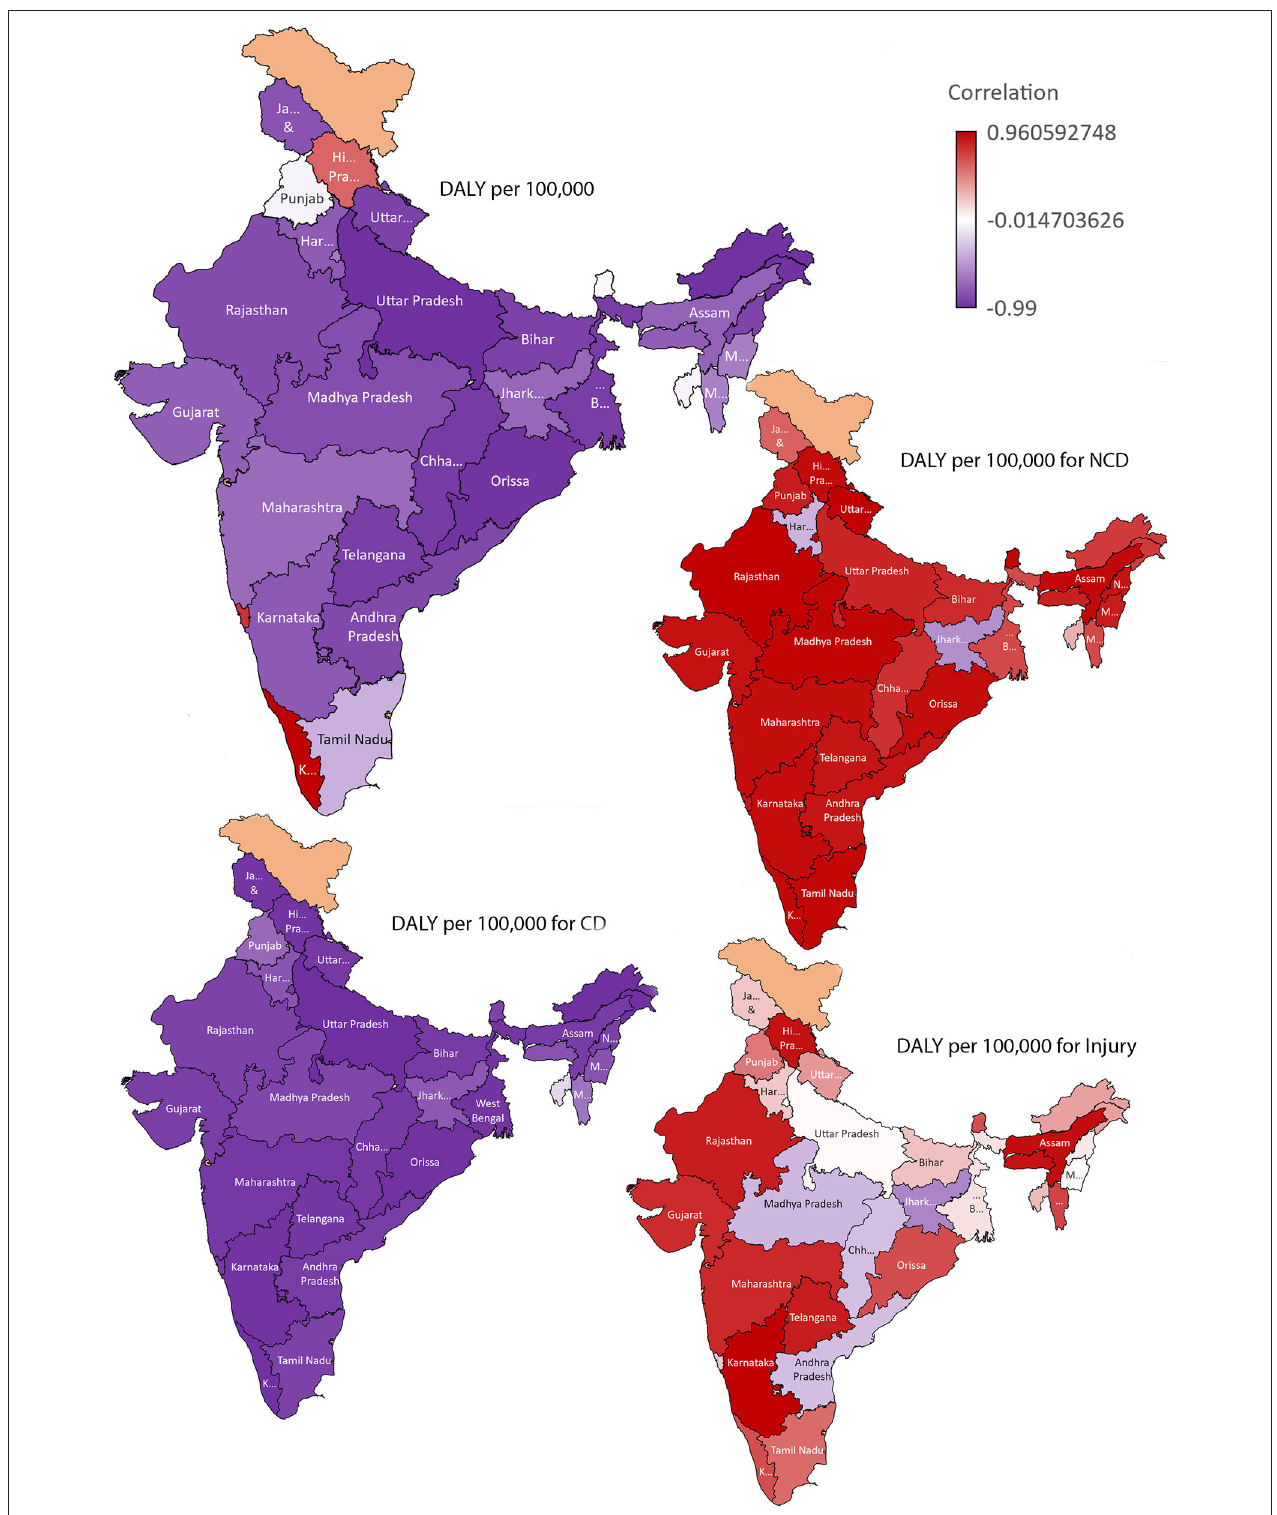
FIGURE 2 | Correlation between budget allocation and disease burden (estimated as DALY) per 100,000 population in India: for Total, Non-Communicable diseases (NCD), Communicable diseases (CD) and injuries.